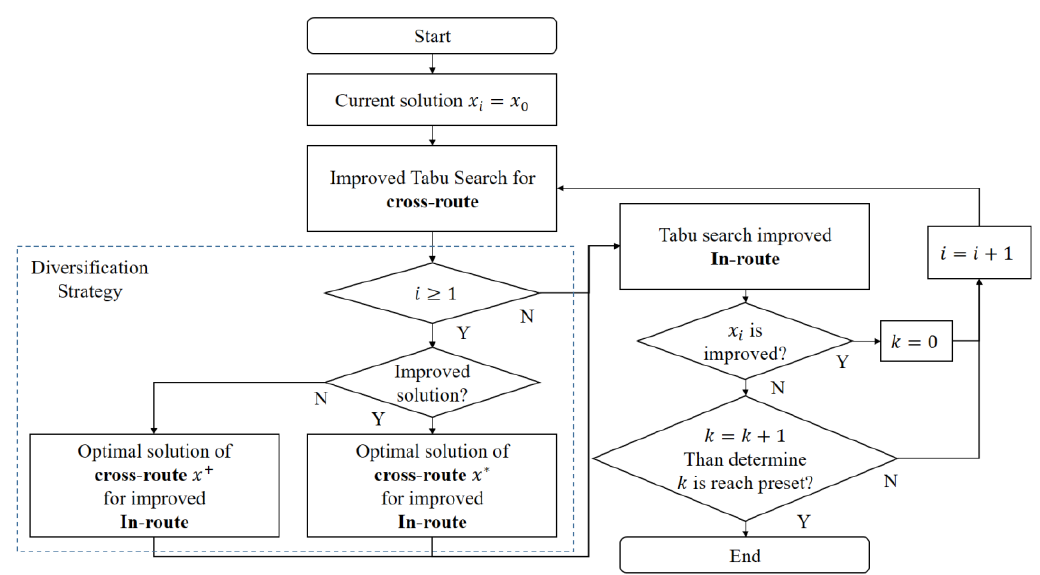
Figure 5. Path Improvement Flow Chart.